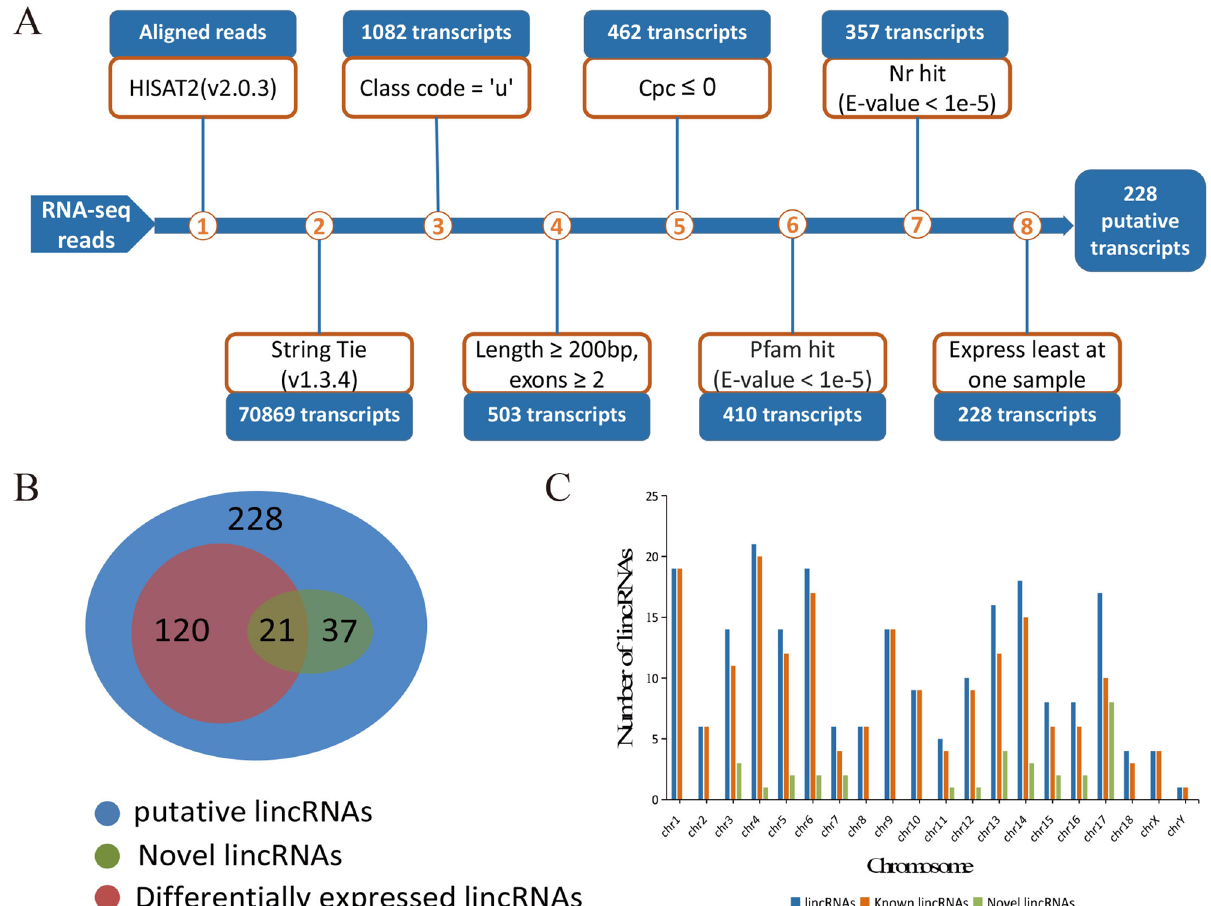
Figure 1. Overview of the identification pipeline for lincRNAs. (A) The identification pipeline of putative lincRNAs; (B) Venn diagram of putative lincRNAs, novel lincRNAs and differentially expressed lincRNAs; (C) The column diagram of chromosome distribution of putative